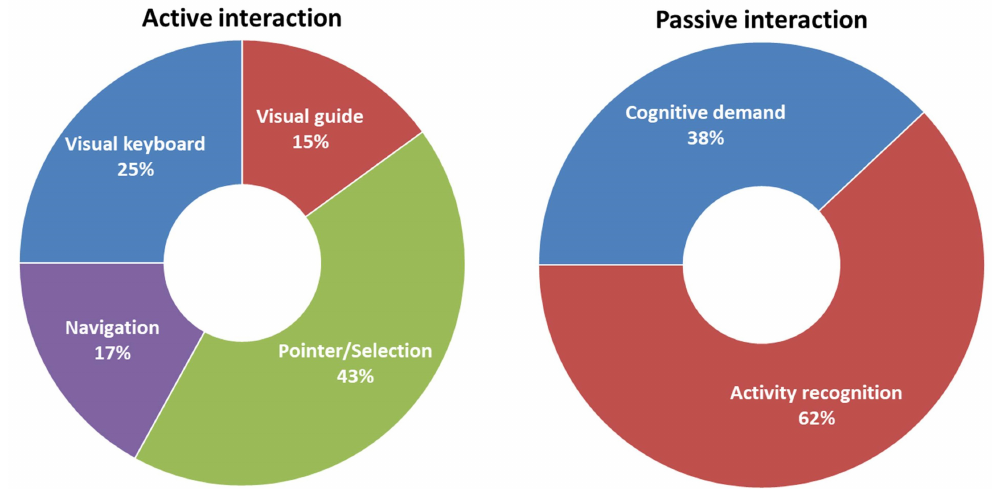
Figure 5. The percentage of each type of active and passive interaction in the included EOG-based BCI publications during the last 20